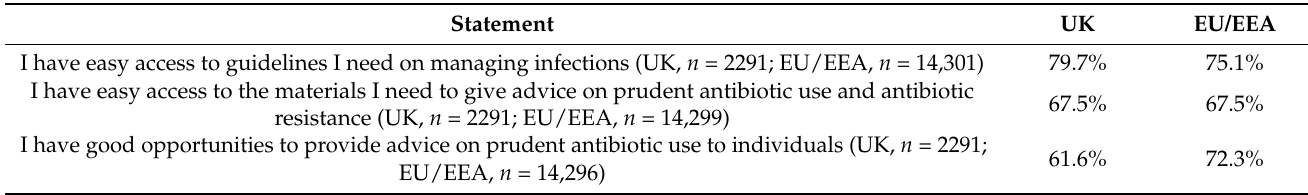
Table 1. Percentage of respondents who agreed or strongly agreed with the opportunity